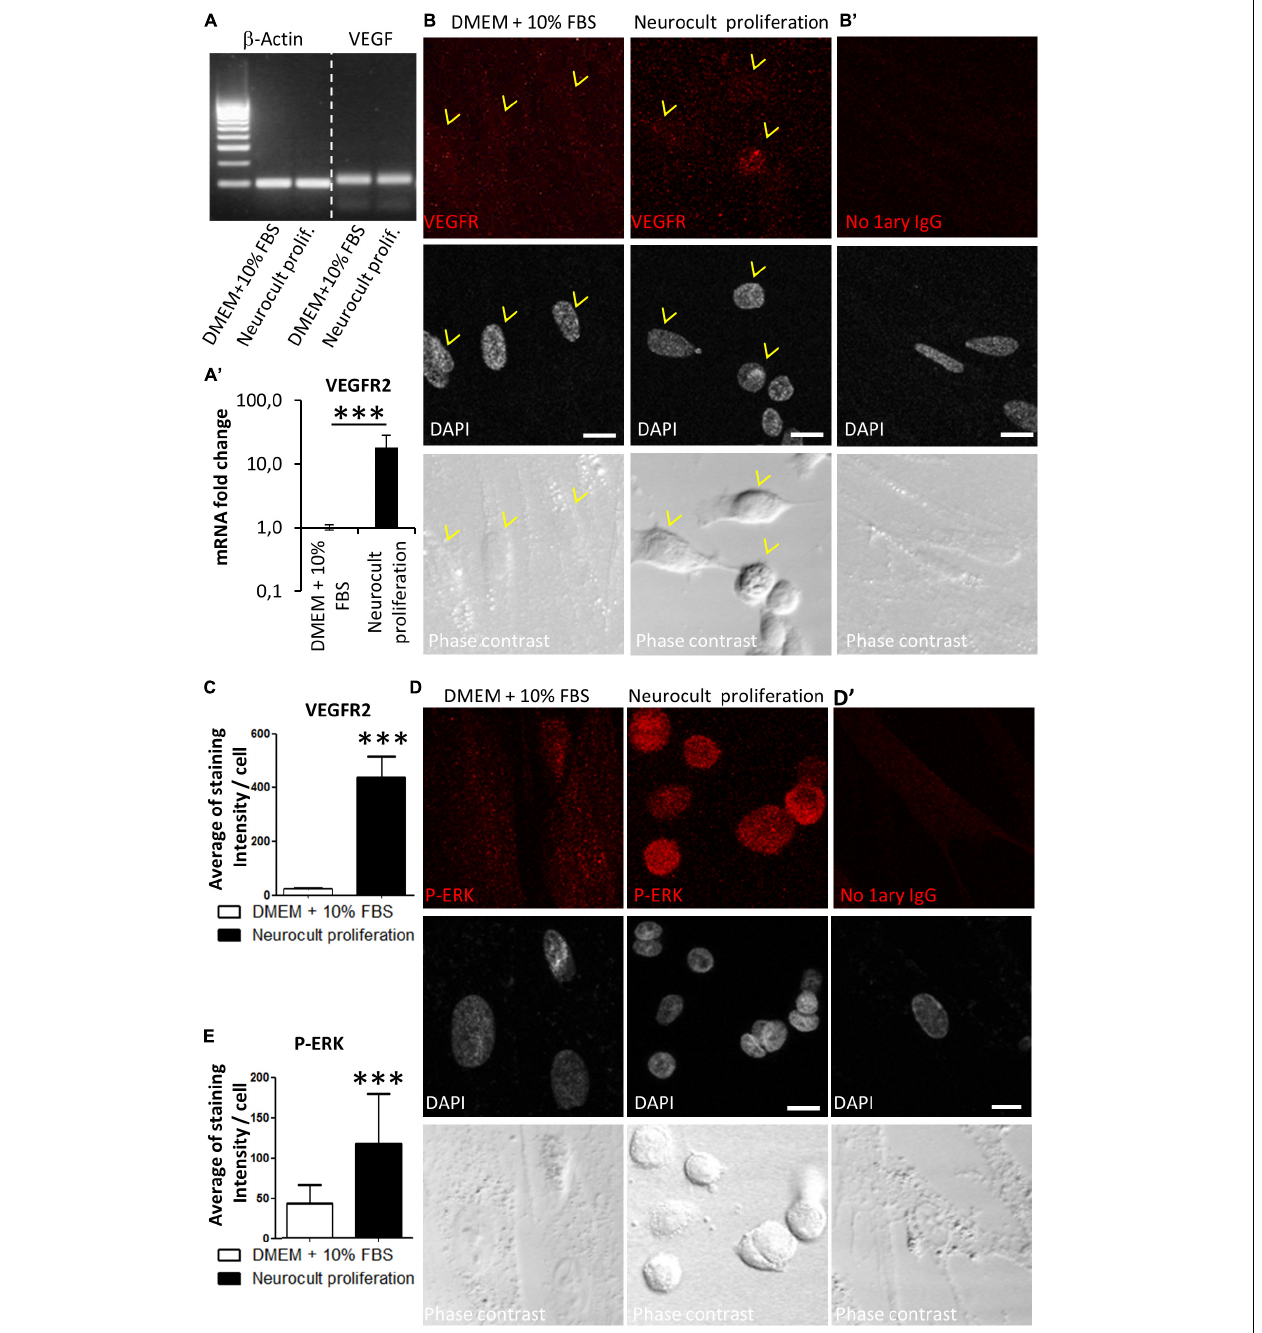
FIGURE 4 | DPSCs grown in Neurocult proliferation increase the expression of VEGFR2 and activate downstream ERK signaling. (A) RT-PCR detection for VEGF, confirming its expression in both DMEM/FBS- and Neurocult-grown DPSCs. (A’) mRNA fold change of the endothelial marker VEGFR2 on DPSC cultures depending upon the type of media: DMEM/FBS vs. Neurocult proliferation. Axis represented as logarithmic scale (mean ± SEM of three independent samples, ∗∗∗ p = 0.0002, one-tailed, Mann–Whitney test). (B) Immunofluorescence of VEGFR2 receptor staining for cells grown during 7 days with DMEM + 10% FBS ( left ) or Neurocult proliferation ( right ). (B’) Control with no 1 ary antibodies. Scale bar 10 µ m. (C) Quantification of distribution of the average amount of bright pixels per cell corresponding to VEGFR2 staining ( n = 33 cells for DMEM + 10% FBS and n = 69 cells for Neurocult proliferation, ∗∗∗ p = 0.0001, one-tailed, Mann–Whitney test). (D) Immunofluorescence of phospho-ERK1/2 showed an increase of staining for cells grown with Neurocult proliferation medium, in contrast to DMEM + 10% FBS DPSCs. Scale bar 10 µ m. (D’) Control with no 1 ary antibodies. Scale bar 10 µ m. (E) Quantification of distribution of the average of bright pixels per cell corresponding to phospho-ERK1/2 staining ( n = 30 cells for DMEM + 10% FBS and n = 47 cells for Neurocult proliferation of three independent samples. ∗∗∗ p = 0.0001, one-tailed, Mann–Whitney test).